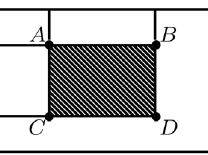
Figure 4. Integral image. The value I ( x , y ) at any point ( x , y ) is the sum of all the pixels above and to the left of ( x , y )